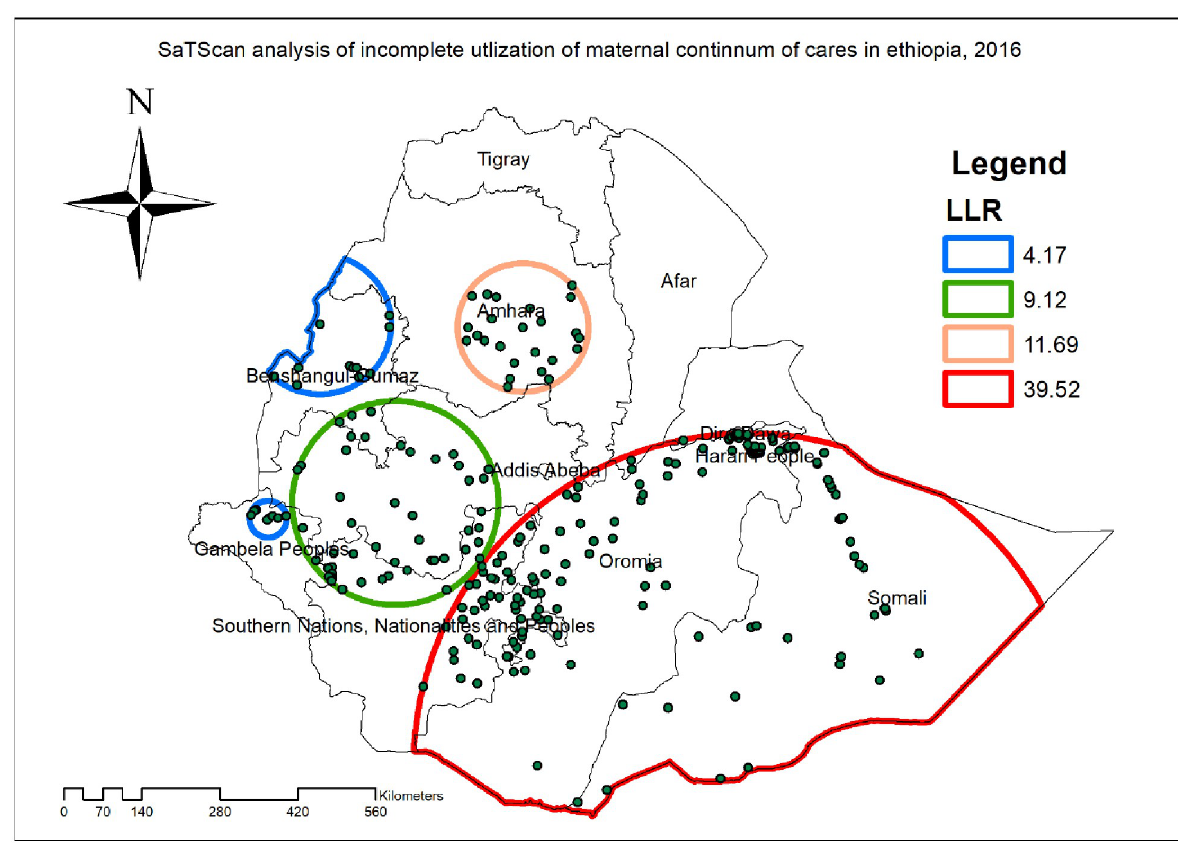
Fig 4. Kriging interpolation of incomplete utilization of maternal continuum of care in Ethiopia, produced using Arc GIS version 10.7.